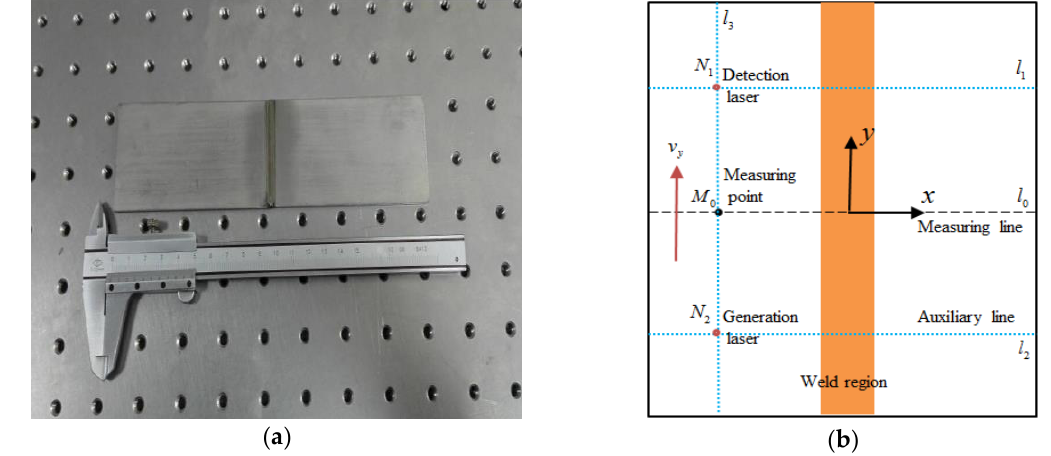
Figure 5. ( a ) Experimental specimen and ( b ) layout of measuring line when measuring the velocity where M 0 is a measurement point; l 0 is the measuring line; l 1 , l 2 , and l 3 are the auxiliary lines; and N 1 v , where M is a measurement point; y 0 and N 2 are the positions of the laser lines; and N and N are the positions of the laser beam. 1 2